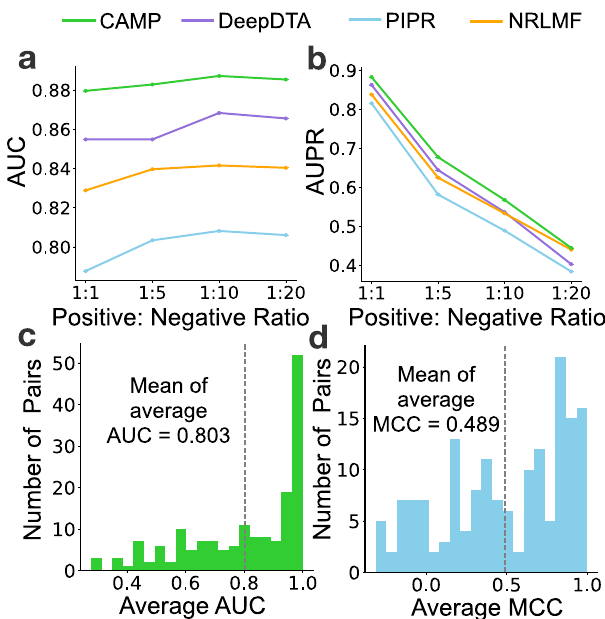
Fig. 4 CAMP yielded robust performance and outperformed the baseline models on an independent test set. a , b show the evaluation results with different positive-negative ratios of the test data set in terms of AUC and AUPR, respectively. c , d show the distributions of AUC and MCC for peptide-binding residue prediction, respectively. The mean values of average AUC and MCC are plotted with dotted lines.